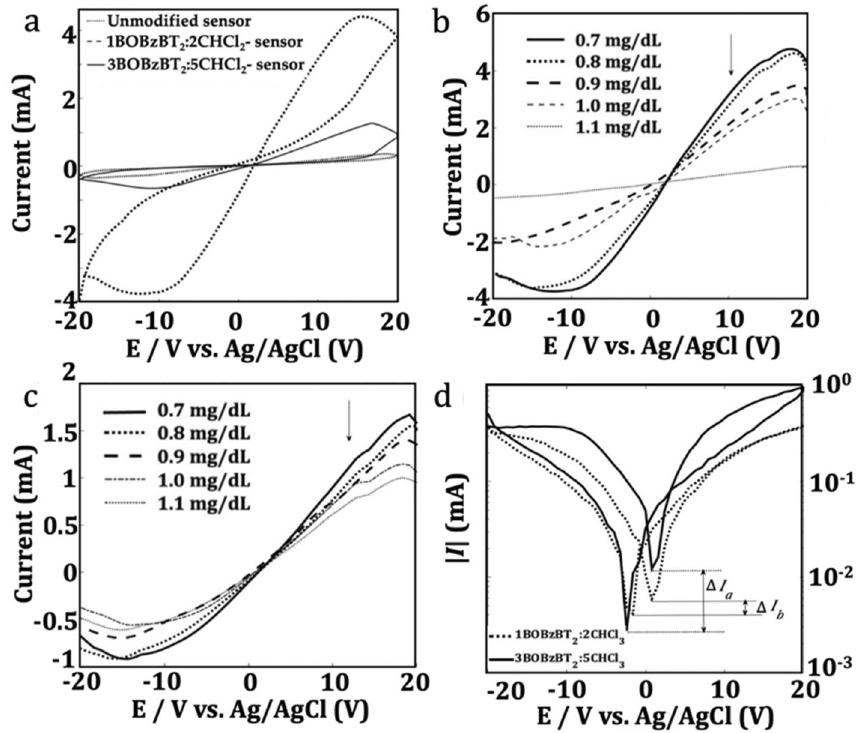
Figure 5. ( a ) Hysteresis loop obtained from performing CV measurement on the unmodified-sensor, 1BOBzBT 2 :2CHCl 3 -sensor and 3BOBzBT 2 :5CHCl 3 -sensor, respectively, using creatinine concentration of 0.7 mg dL −1 . I – V curves using four creatinine concentrations for ( b ) 1BOBzBT 2 :2CHCl 3 -sensor and ( c ) 3BOBzBT 2 :5CHCl 3 -sensor, where only the reverse voltage output is shown. ( d ) I – V curves with log-scale vertical axis using creatinine concentration of 0.7 mg dL −1